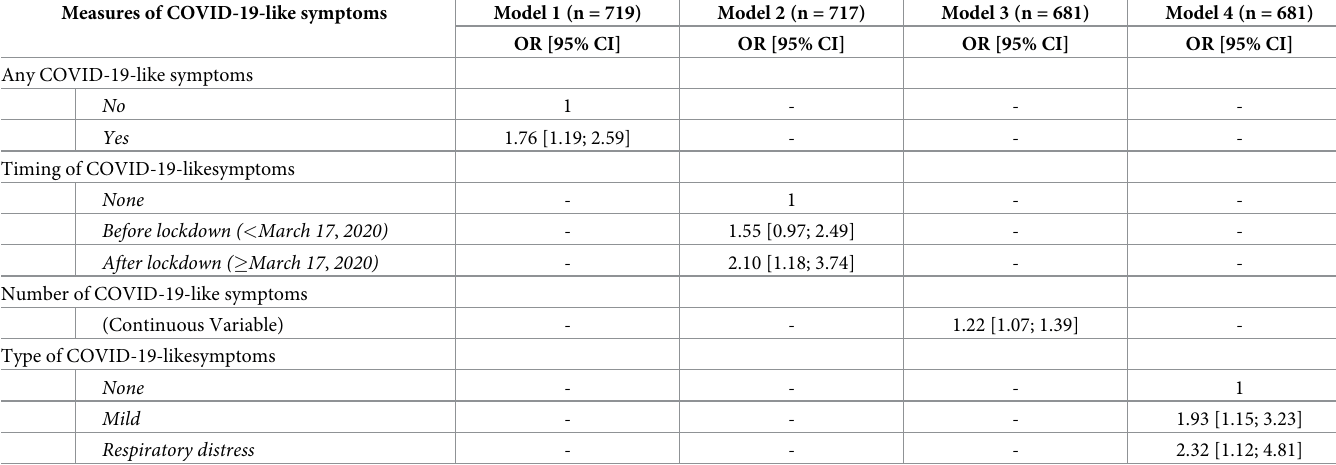
Table 2 provides the results of all four bivariate GEE models for each measure of COVID- 19-like symptoms. COVID-19-like symptoms were associated with anxiety/depression regard- less of the indicator considered: any COVID-19-like symptoms, COVID-19-like symptoms after lockdown, number of COVID-19-like symptoms, and mild symptoms as well as respira- tory distress. After adjustment ( Table 3 ), any COVID-19-like symptoms remained associated with anxiety/depression during lockdown (66% increased odds), as were COVID-19-like symptoms after the beginning of lockdown (91% increased odds), the number of COVID- 19-like symptoms (19% increased odds for each additional symptom). All types of COVID- 19-like symptoms were not found associated with anxiety/depression but the significance is close: mild symptoms: OR = 1.71, 95% CI = 0.96–3.05, respiratory distress: OR = 1.96, 95% CI = 0.93–4.15. In the sensitivity analysis using the first rather than the latest available infor- mation on participants’ history of anxiety/depression, results are very similar and the conclu- sions the same (S3 Table) .